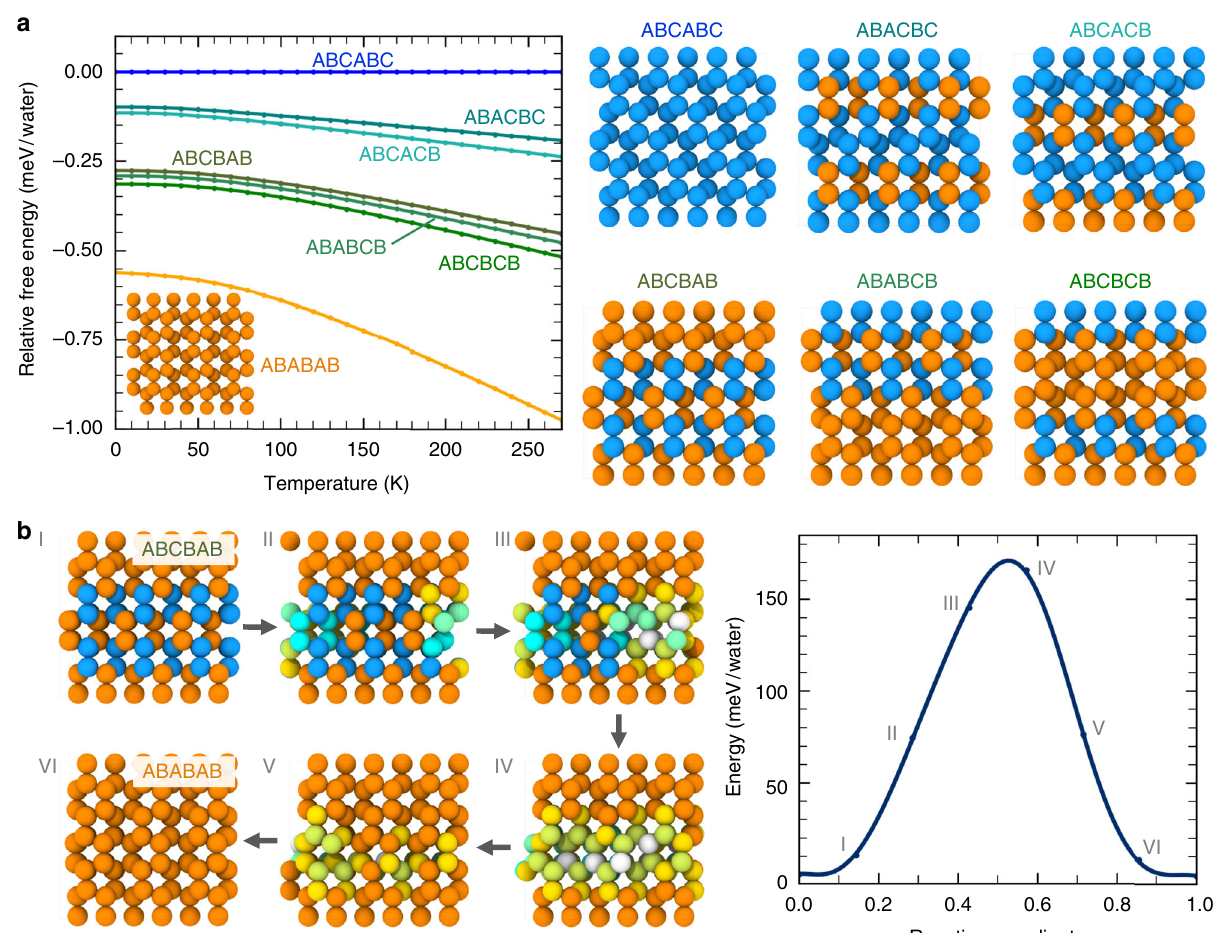
Fig. 6 Thermodynamics of various ice phases and activation barrier computed using ML-BOP dih . a Free energies of various stacked disorder ice phases, I c , and I h at different temperatures, relative to I c . Molecular con fi gurations of the various phases are also provided. b Molecular pathway, and the associated energy barrier for elimination of a stacking fault plane in I h . Selected con fi gurations along the pathway are shown on the left, while potential energy along this preferred pathway (obtained by CI-NEB calculations in the framework of ML-BOP dih ) is shown on the right. All the molecules are colored based on their local coordination using the same scheme as Fig.